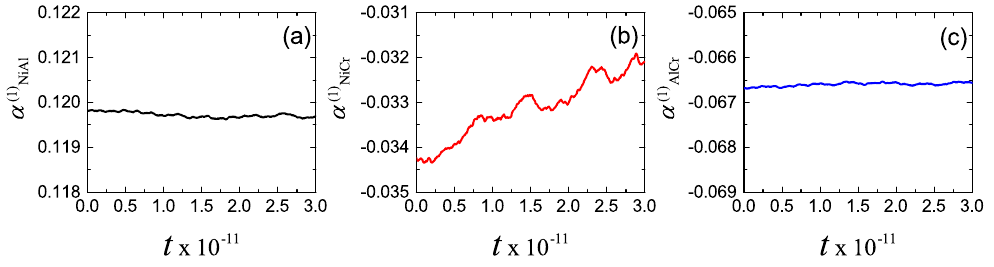
( 1 ) ( 1 ) , ( b ) α and NiCr NiAl